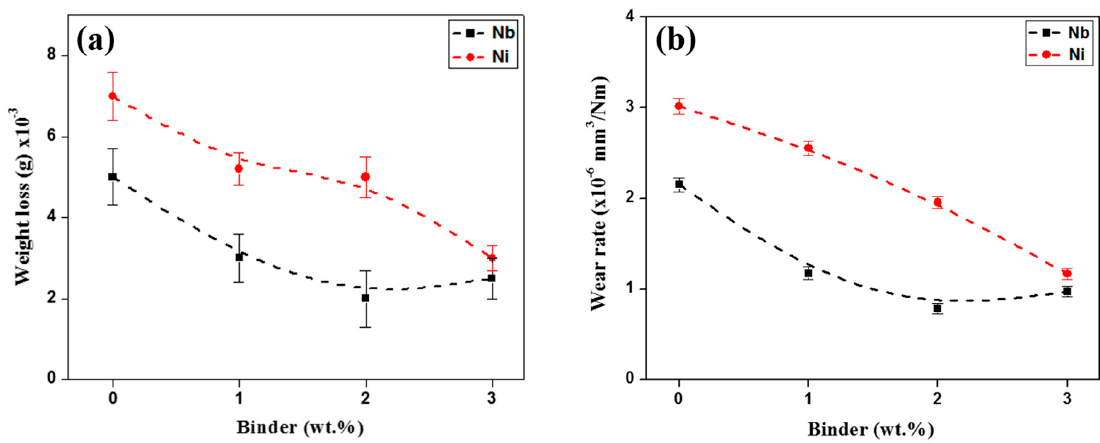
Figure 8. Plots showing the effect of Nb and Ni binder on the ( a ) weight loss and ( b ) abrasion rate on Al 2 O 3 -10TiC composite samples.